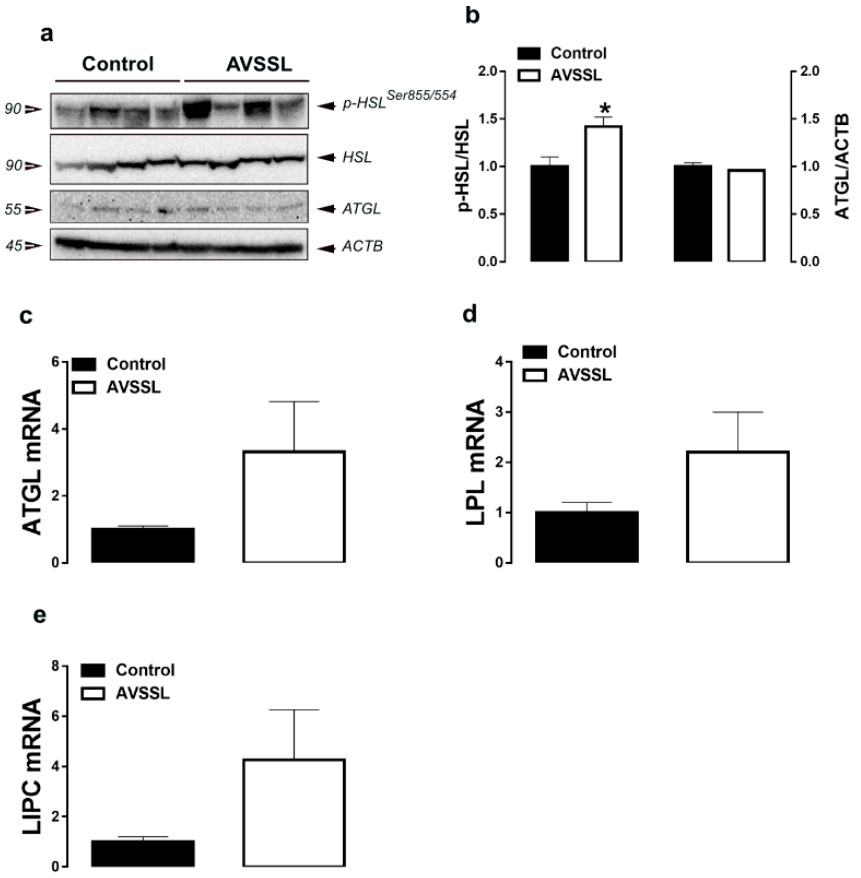
Figure 3. Effect of the phytogenic water additive AVSSL on the expression of lipolysis-related proteins and genes in adipose tissue. Protein levels ( a , b ) were measured by Western blot and mRNA abundances ( c – e ) were determined by qPCR using the 2 − ∆∆ Ct method [21]. Data are presented as the mean ± SEM ( n = 8 birds/ group). * Denotes significant difference compared to the control group at p < 0.05. ATGL, adipose triglyceride lipase; HSL, hormone-sensitive lipase; LPL, lipoprotein lipase; LIPC, lipase C.